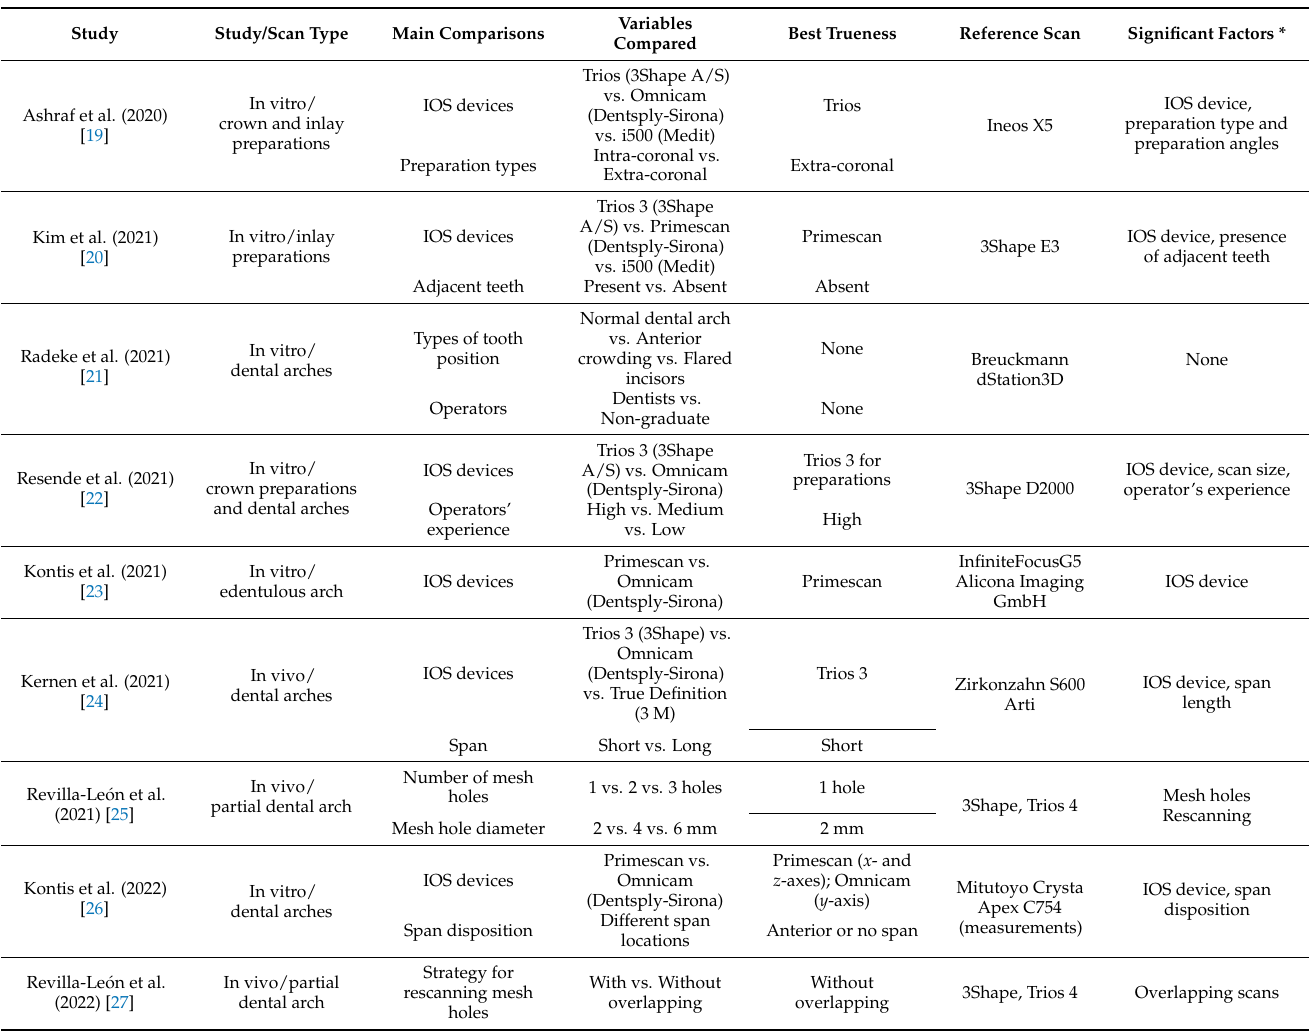
Table 1. Characteristics of the studies assessed.